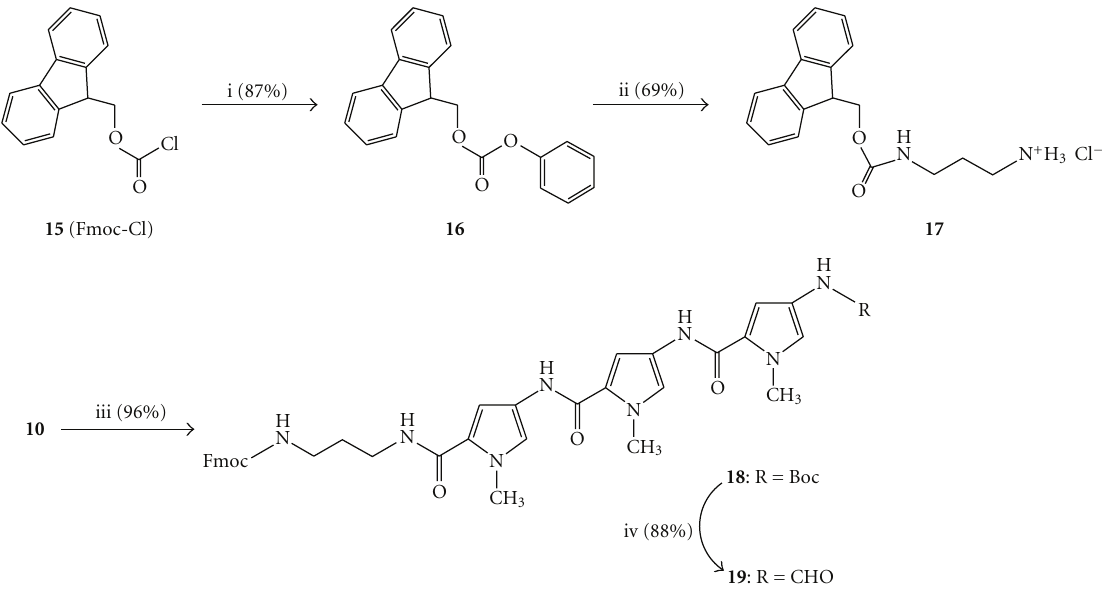
Scheme 3: Reaction conditions (i) sodium phenoxide, 1,4-dioxane, rt, 1.5 hours. (ii) 1. Propane-1,3-diamine (1.1 eq.), rt, 3.5 hours; 2. pyridinium hydrochloride. (iii) 17 , DCC, HOBT, DIEA, DMF, rt, 24 hours. (v) 1. AcCL, MeOH, 0 ◦ C, 30 minutes; 2. HCOOH, CDI, THF, − 40 ◦ C, 1 hour.